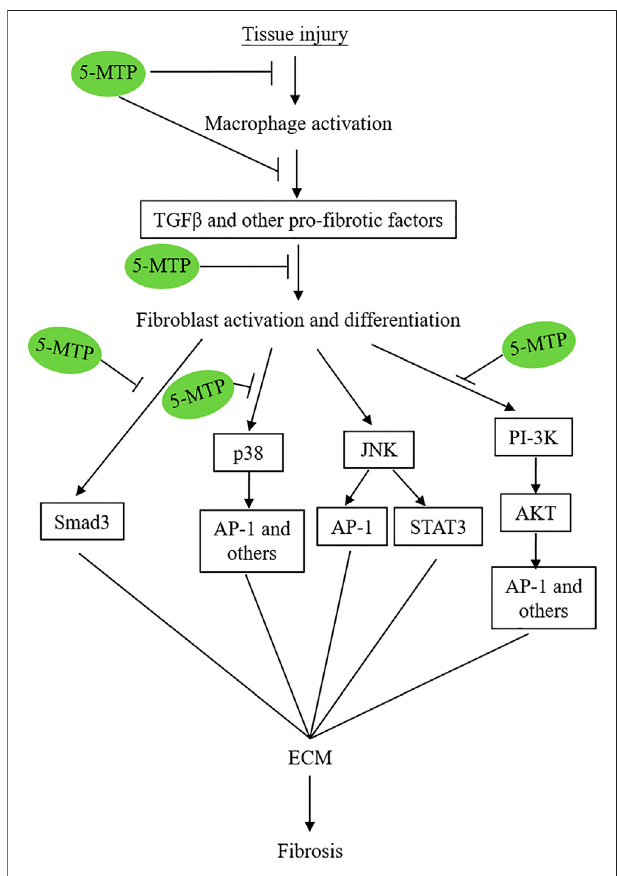
FIGURE 4 | Simpli fi ed graphic scheme illustrating the 5-MTP targets via which it attenuates tissue-injury-induced tissue fi